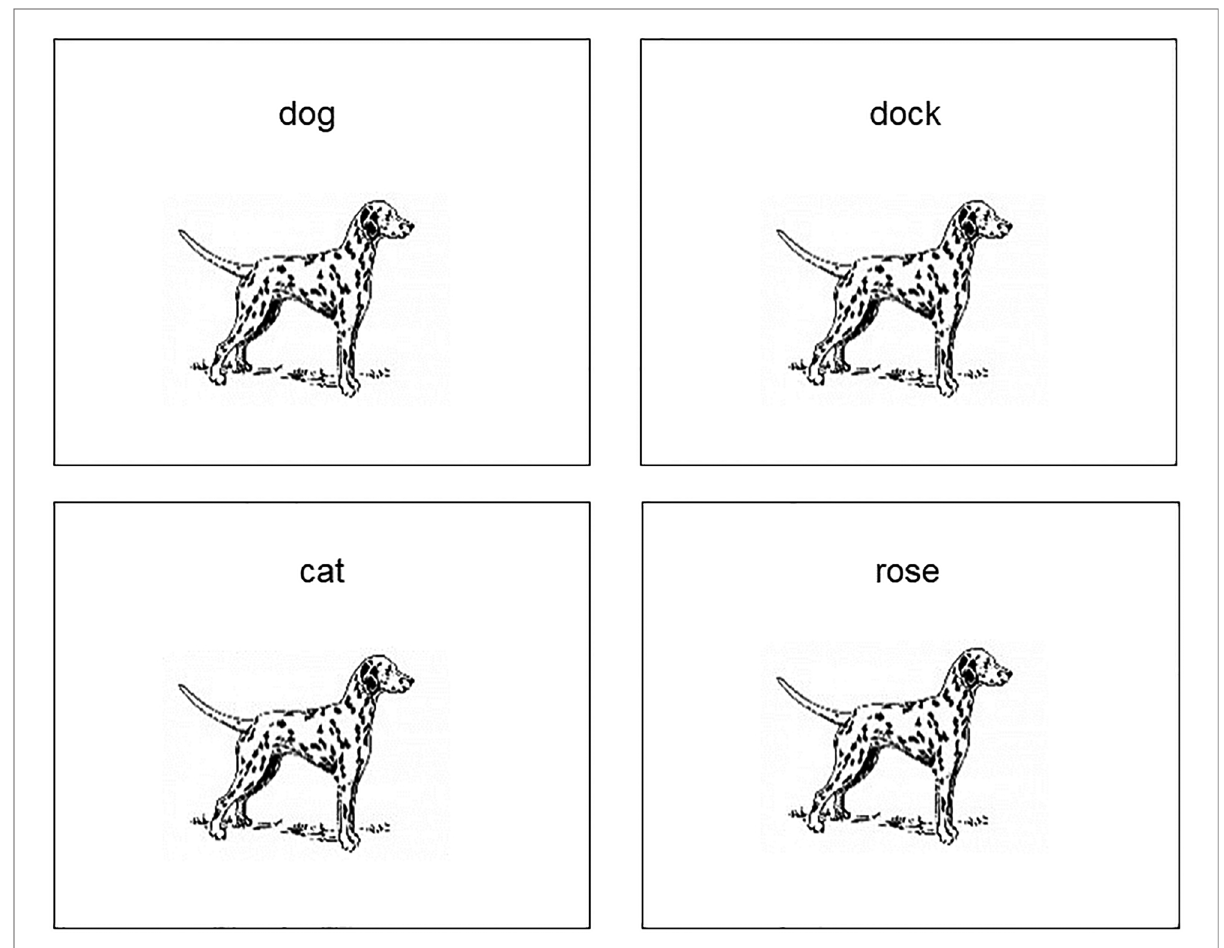
FIGURE 1 Example of separate rWPVT trials for a single picture with the target (top left), phonological foil (top right), semantic foil (bottom left), and unrelated foil (bottom